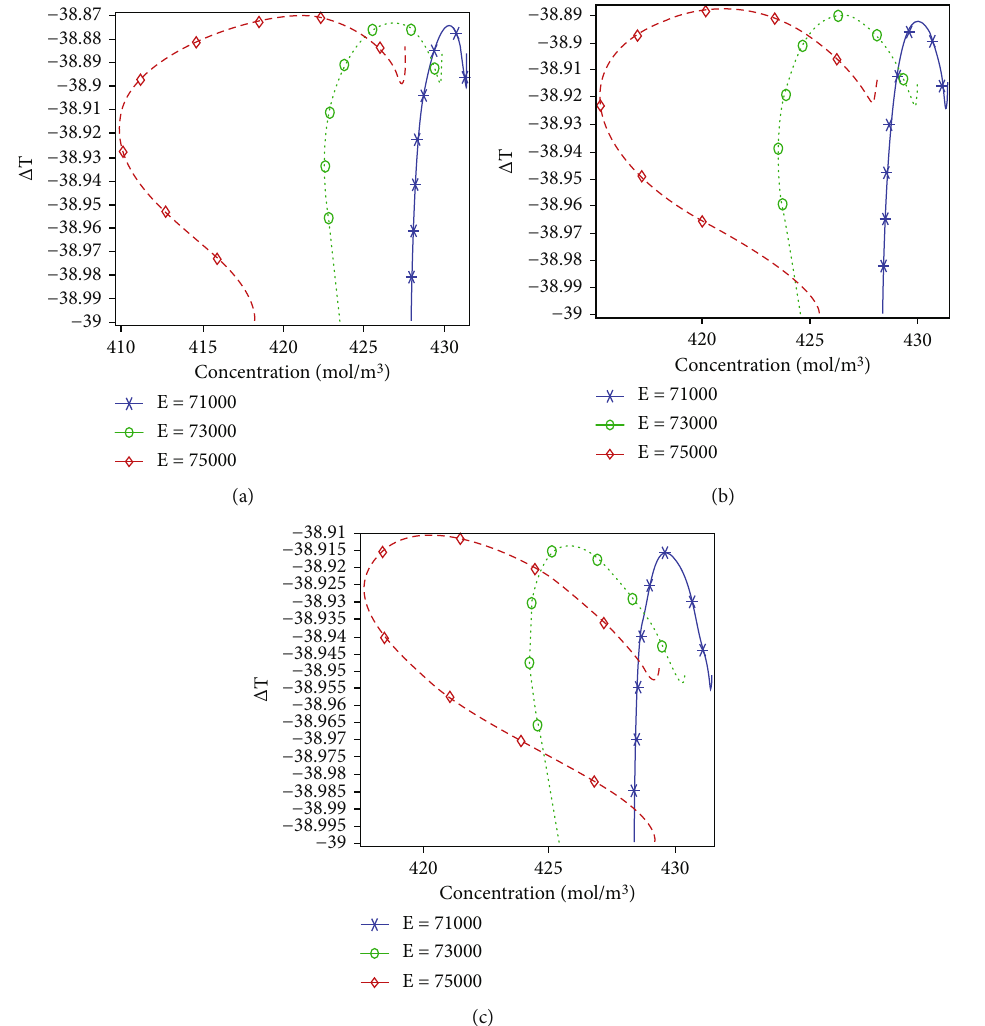
Figure 9: Change in the temperature at downstream along the backward step channel against the concentration of calcium hydroxide at (a) Re = 100 , I : C = 1 % , a = 0 : 5 ; (b) Re = 100 , I : C = 1 % , a = 0 : 6 ; and (c) Re = 100 , I : C = 1 % , a = 0 : 7